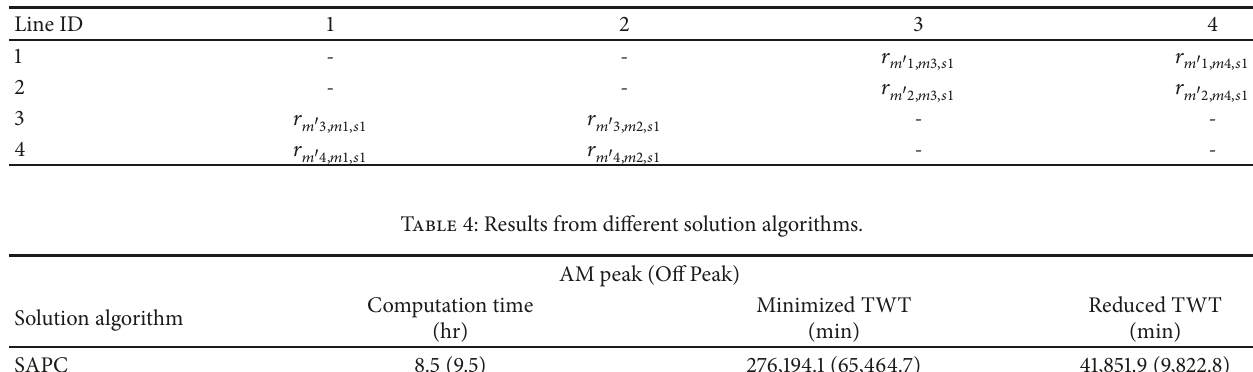
Table 3: Train-to-train transfer demand at station 푠 1 .